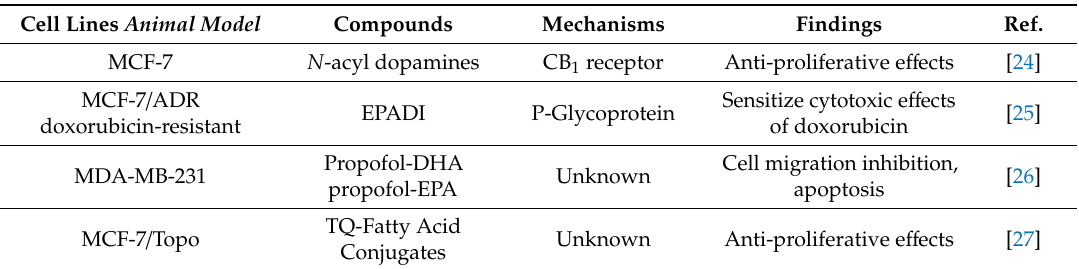
Figure 1. Flow diagram of the search strategy. Keywords used in PubMed database were “Fatty acid derivatives” AND “cancer”, “Fatty acid derivatives” AND “breast cancer”, “Fatty acid omega 3 derivatives” OR “Fatty acid omega 3 conjugates” OR “Fatty acid omega 3 amides” AND “breast cancer”. Finally, 32 papers were deemed eligible to be reviewed. Table 1. “In vitro” and “in vivo” studies showing the effects and the suggested mechanisms of polyunsaturated fatty acid derivatives in breast cancer.